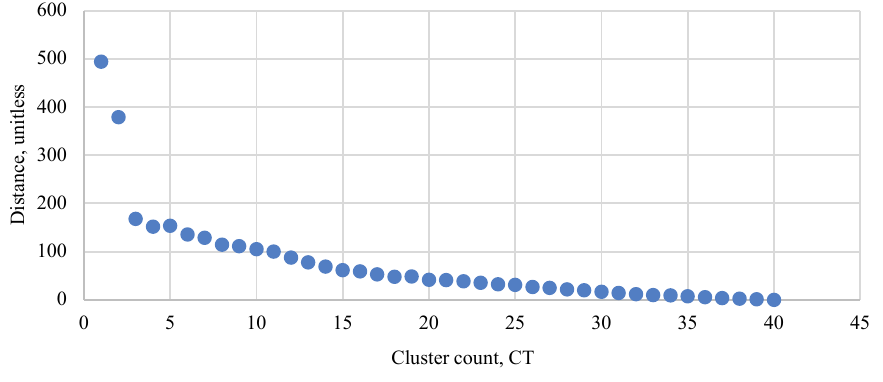
Fig. 5. Cluster combinations of Delphin simulations